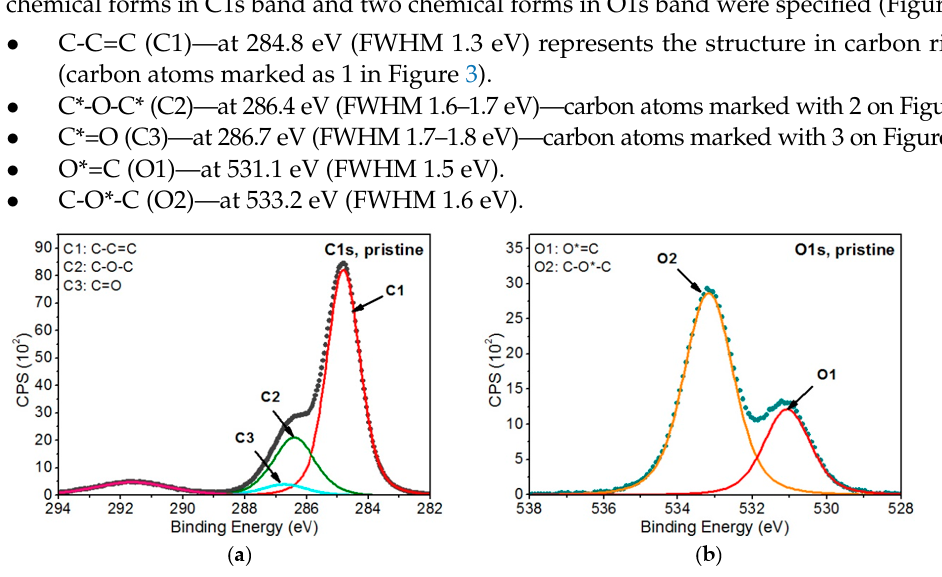
Table 1. Binding energy range, FWHM range, and atomic concentration of different functional groups for pristine PEEK and modified PEEK (pristine PEEK peaks given in rows with blue background).